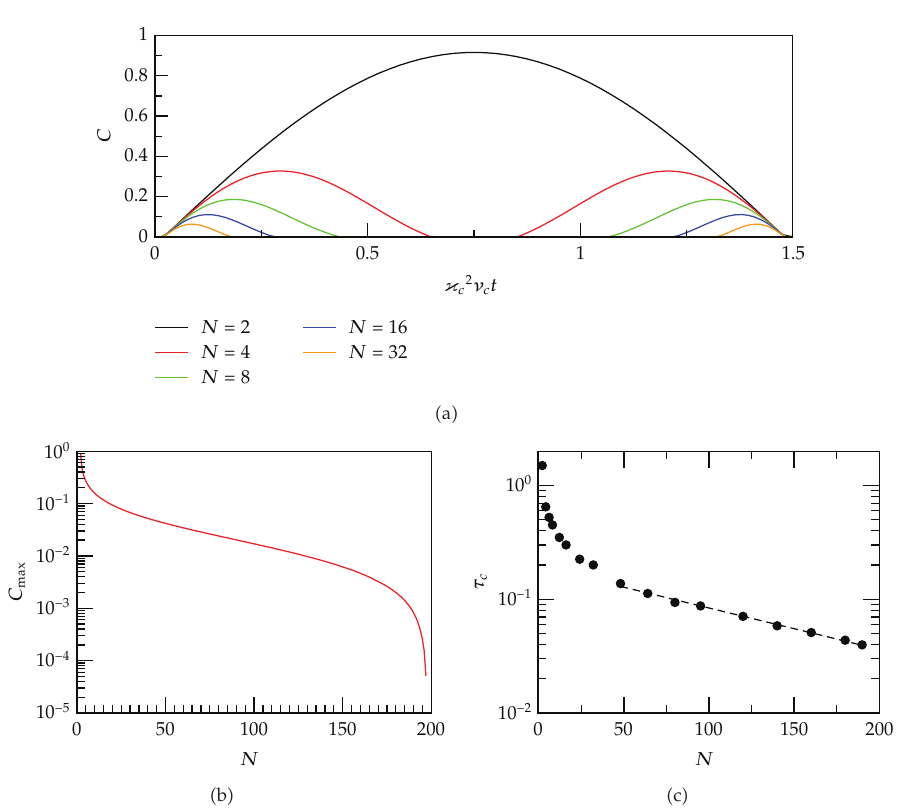
Figure 3: (cid:2) a (cid:3) Concurrence as a function of the rescaled time, for fixed (cid:9) (cid:8) ν c /ν T (cid:8) 1, being respectively the cut-o ff and thermal frequency (cid:2) ν T (cid:8) k B T/h with T (cid:8) 300 K (cid:3) and the form factor, f c (cid:2) k (cid:3) (cid:8) are p (cid:8) 0 . 5, v (cid:8) 0 . 48, κ c (cid:8) 0 . 05. (cid:2) b (cid:3) Plot of the concurrence at the peak (cid:2) obtained from (cid:2) a (cid:3)(cid:3) as a function of the number of spins N . (cid:2) c (cid:3) Plot of the collapse time, τ c , as a function of the number of spins, N . The dashed line is the best fit exp (cid:2) − αN (cid:3) with α (cid:8) 0 . 0838 ± 0 . 0002.